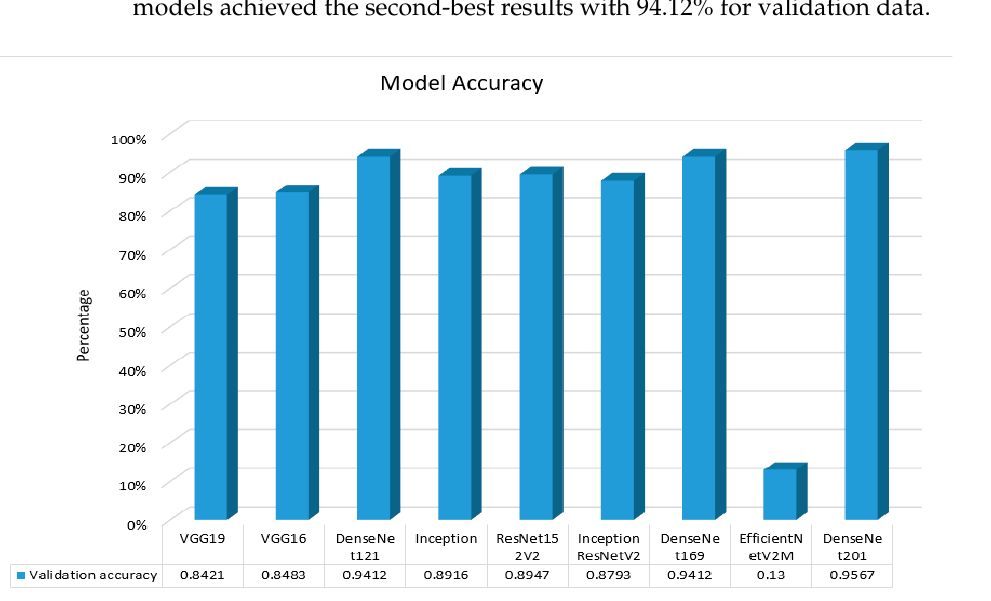
Table 8. DenseNet layers’ accuracy.